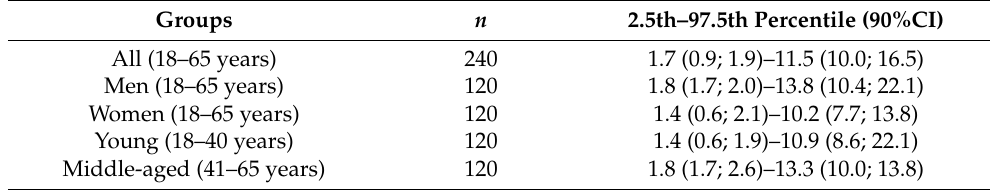
Table 1. Reference intervals for IF in serum.